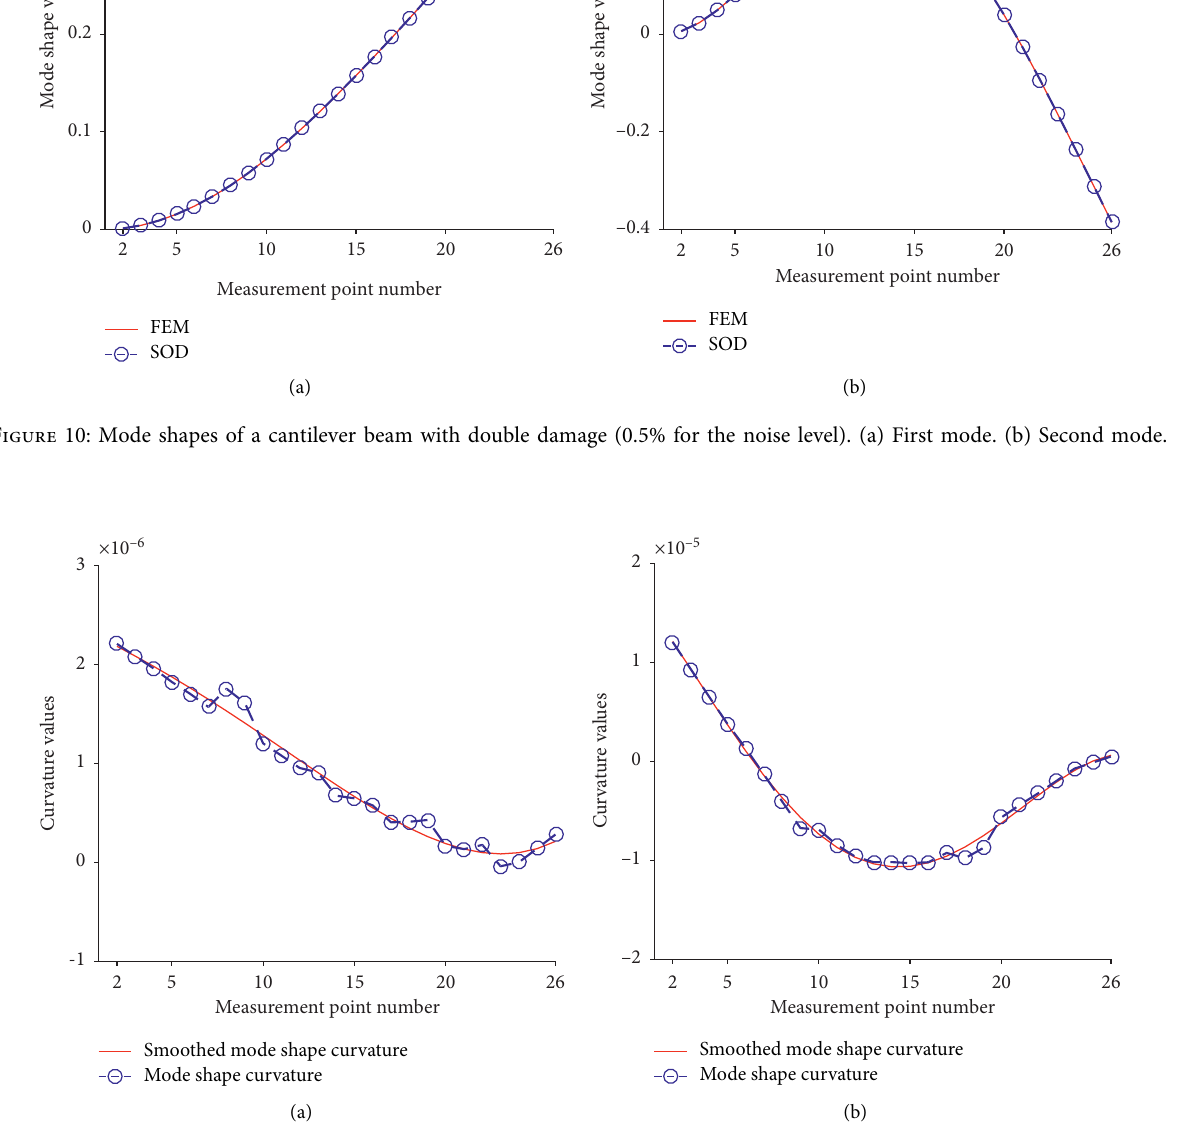
Figure 11: Mode shape curvatures of a cantilever beam with double damage (0.5% for the noise level). (a) First mode. (b) Second